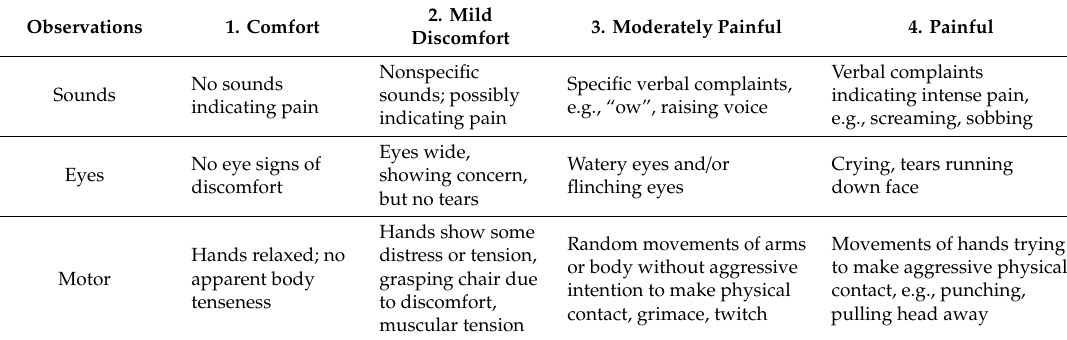
Table 2. The SEM scale [24] used to measure pain and